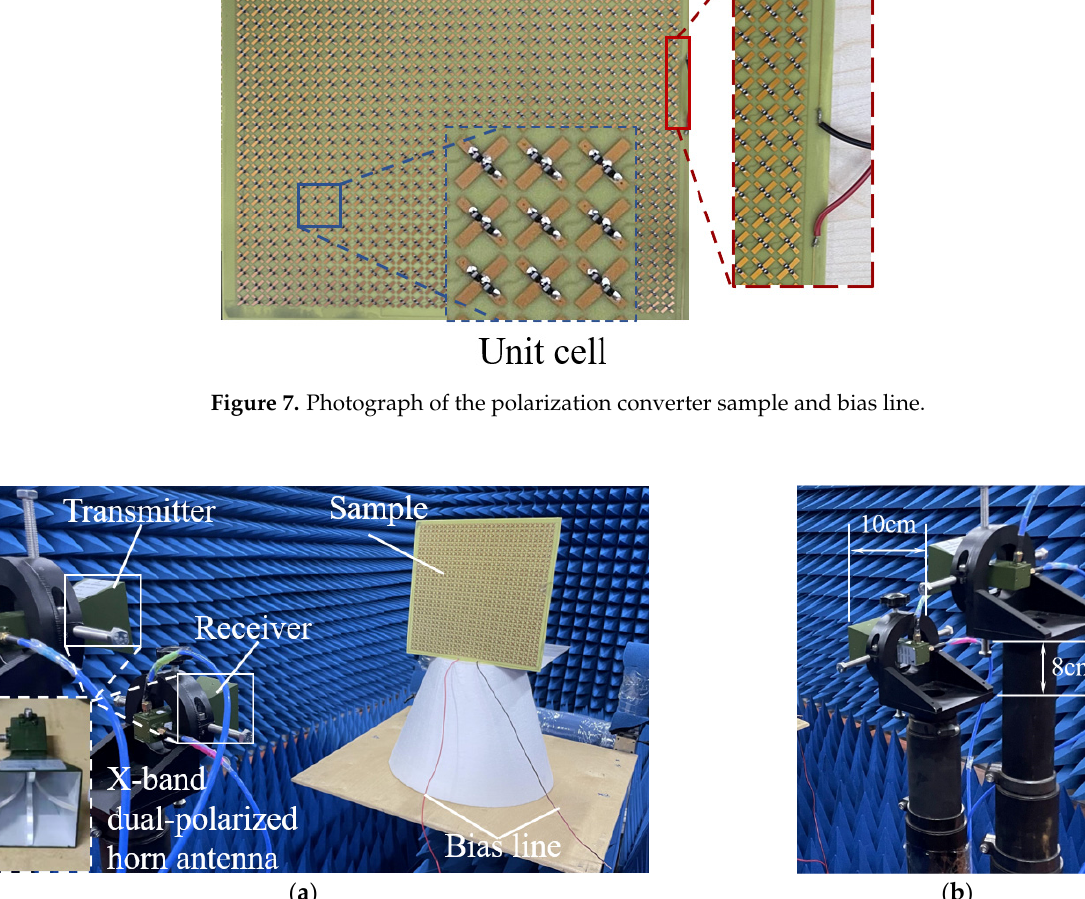
Figure 7. Photograph of the polarization converter sample and bias line.